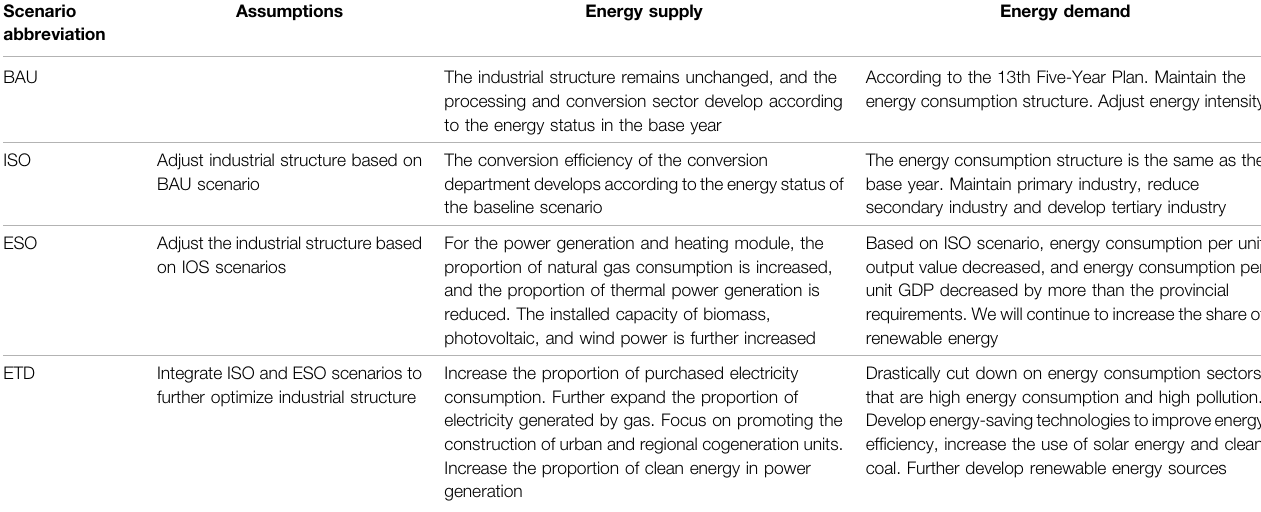
TABLE 2 | Main strategies for scenario construction in various scenarios. Scenario abbreviation